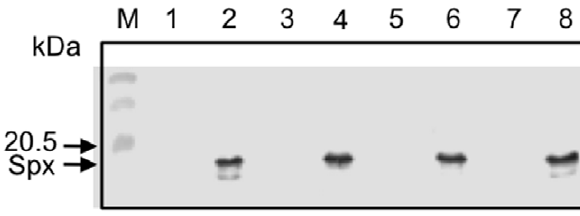
Figure 2. Production of the wild-type and mutant Spx in B. subtilis . B. subtilis cells expressing the wild-type and the mutant Spx DD (the C-terminal two amino acids are substituted with aspartate residues, which renders the Spx protein insensitive to ClpXP protease) were grown in DS medium in the absence (lanes 1, 3, 5, and 7) and the presence of IPTG (lanes 2, 4, 6, and 8) as described in Materials and Methods. The lysate was prepared by the protoplast lysis method as described and 15 m g of total protein was resolved by SDS-polyacryl- amide gel electrophoresis. Western blot analysis was carried out to detect Spx as shown previously. Lanes: M, molecular weight marker; 1 and 2, ORB6894 (Spx DD ), ORB6895 (Spx DD-R60E ), ORB6896 (Spx DD-K62E ), and ORB6897 (Spx DD-K66E